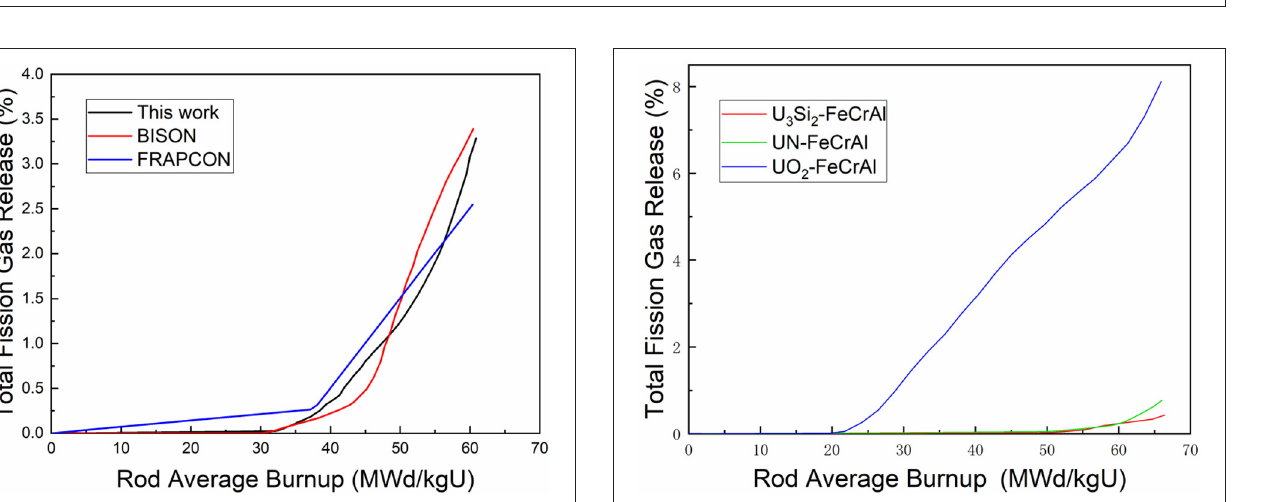
FIGURE 13 | Fission gas release for UN/SiC at 20 kW/m. FIGURE 14 | Fission gas release for different materials at 20